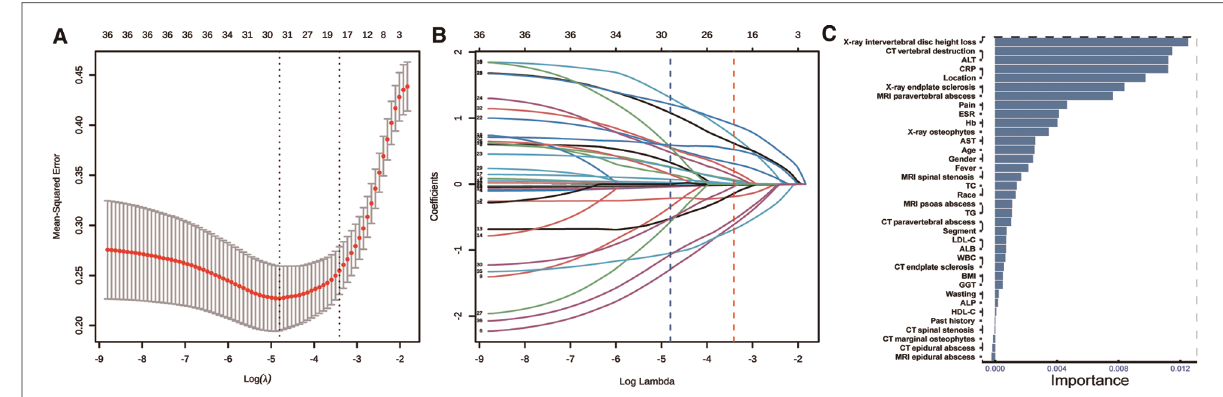
FIGURE 2 Feature selection. ( A ) Optimal parameter (lambda) selection in the LASSO model using 10-fold cross validation via minimum criteria (the left dotted vertical line) and the 1 − SE of the minimum criteria (the right dotted vertical line). ( B ) LASSO coef fi cient pro fi les of the 36 features. A coef fi cient pro fi le plot was produced against the log (lambda) sequence. Nineteen features with nonzero coef fi cients were selected by the optimal λ . ( C ) Features selected using permutation importance via random forest ordered by their importance score. LASSO, least absolute shrinkage and selection